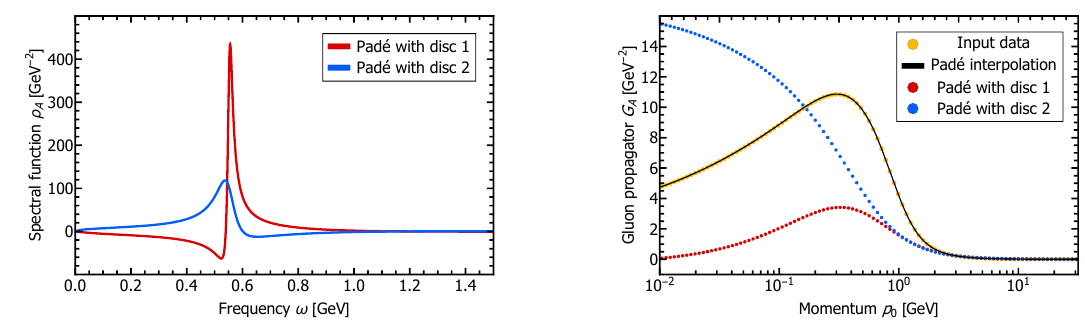
Figure 11: Reconstruction of the gluon propagator via Padé, the difference between the two spectral functions is described in the main text. The left panel shows the spectral functions while the right panel shows the input data, the Padé interpolant and the reconstructions obtained from the spectral